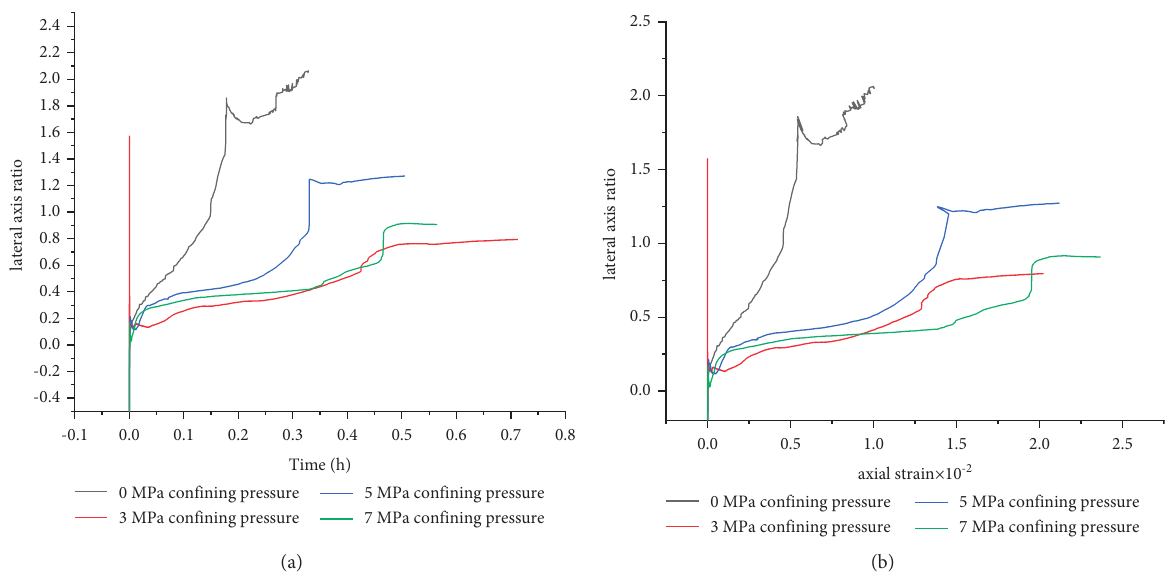
Figure 5: Characteristic curves of lateral axis ratio of coal sample under different confining pressures. (a) Characteristic curve of lateral axis ratio versus time. (b) Characteristic curve of lateral axis ratio versus axial